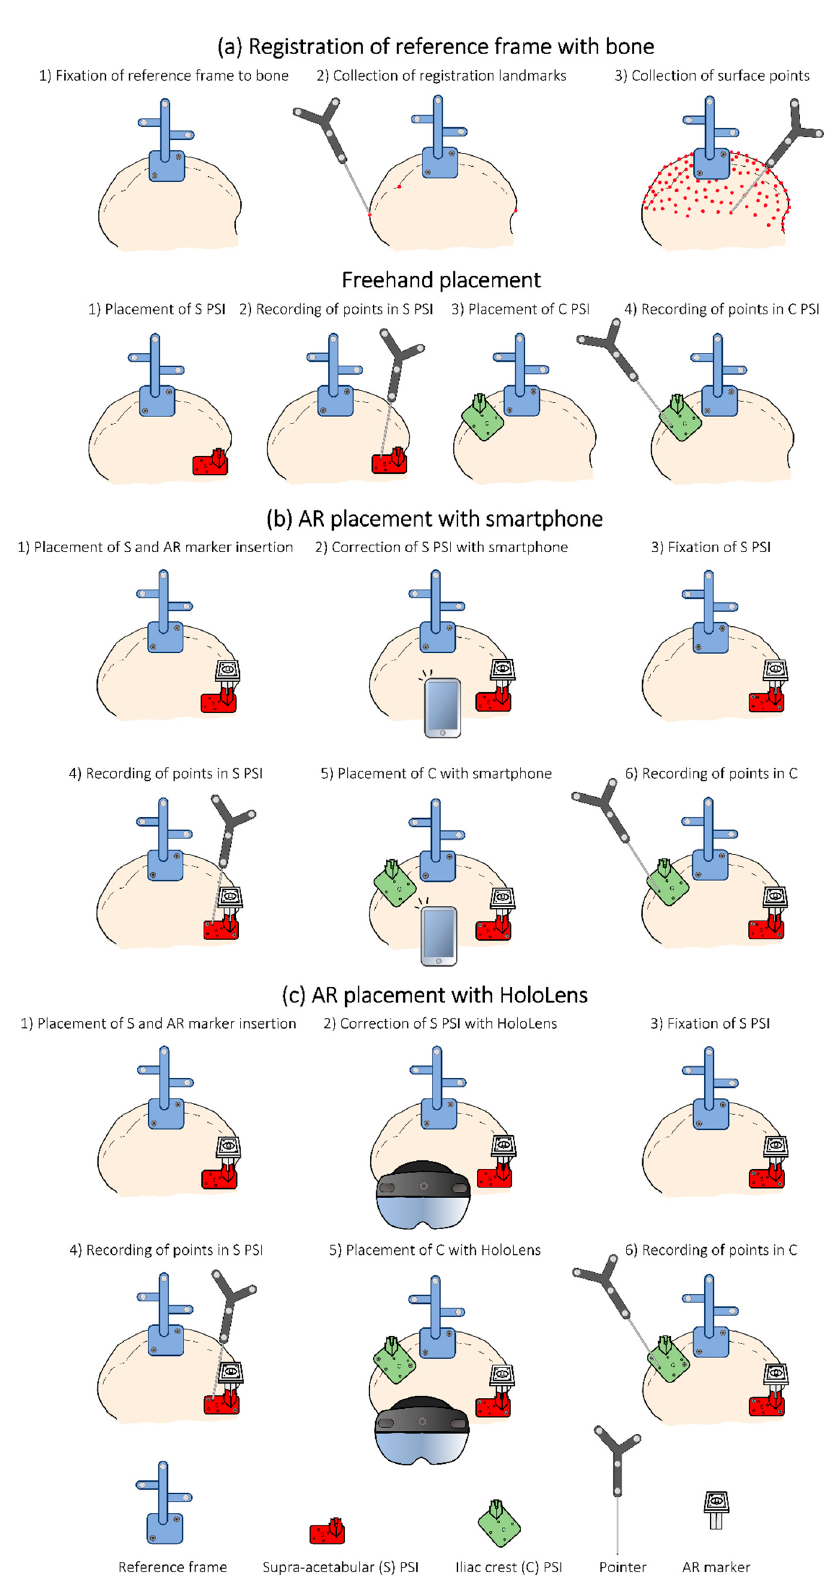
Figure 4. Steps followed during the experiment for registration and to record PSIs placements in each methodology. ( a ) Registration of reference frame with bone, ( b ) AR placement with smartphone, and ( c ) AR placement with HoloLens.